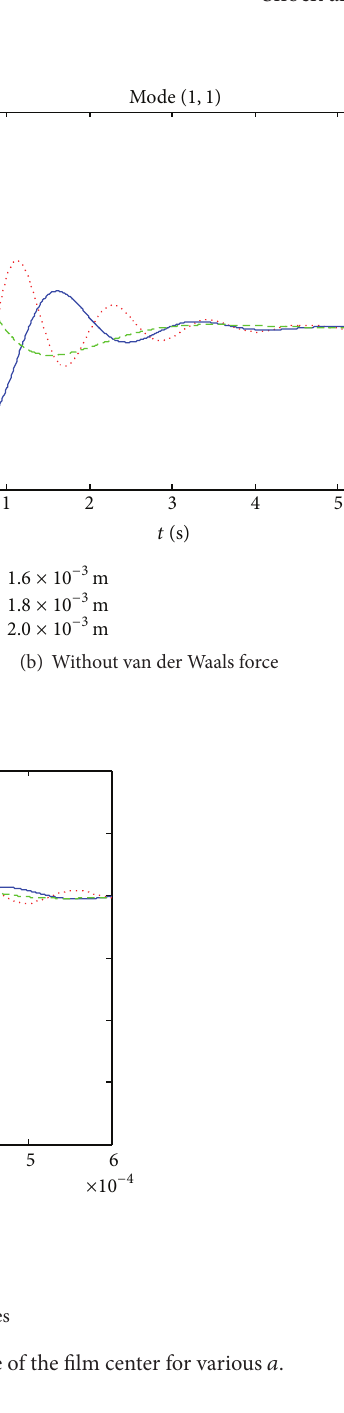
the relative error between the natural frequencies with and without the van der Waals force is 6.59% for mode (1, 1)